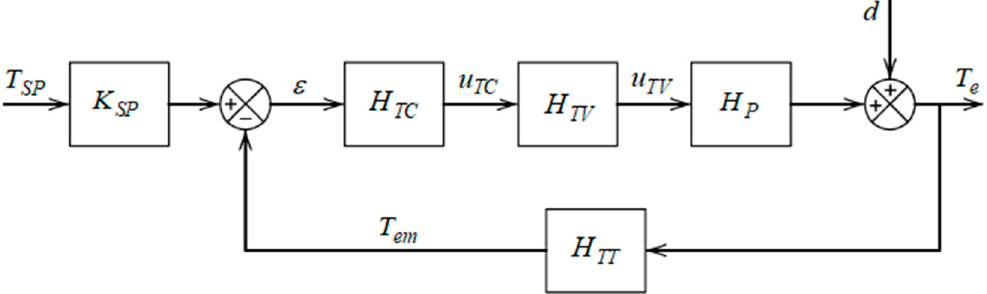
Figure 3. The control block diagram.